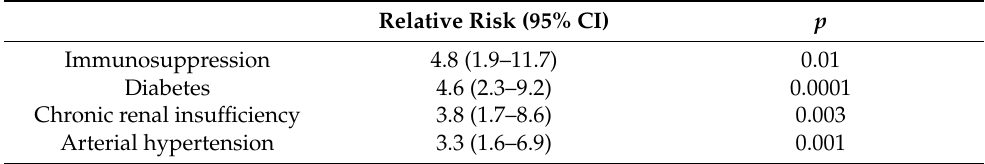
Table 3. Associated comorbidities to hospital